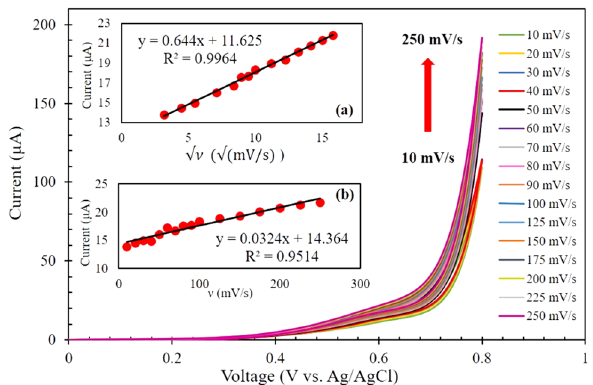
Figure 7. CV responses of CuO/ZnO-DSDSHNM in 0.5 M NaOH at various scan rates ranging from 10 to 250 mVs −1 (10, 20, 30, 40, 50, 60, 70, 80, 90, 100, 125, 150, 175, 200, 225 and 250 mVs −1 ) in 10 mM glucose. Inset: corresponding two plots of anodic peaks versus the ( a ) square root of scan rate and ( b ) scan